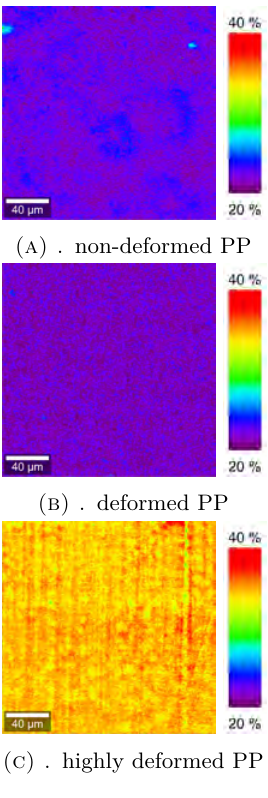
Figure 2. Crystallinity α calculated from Raman